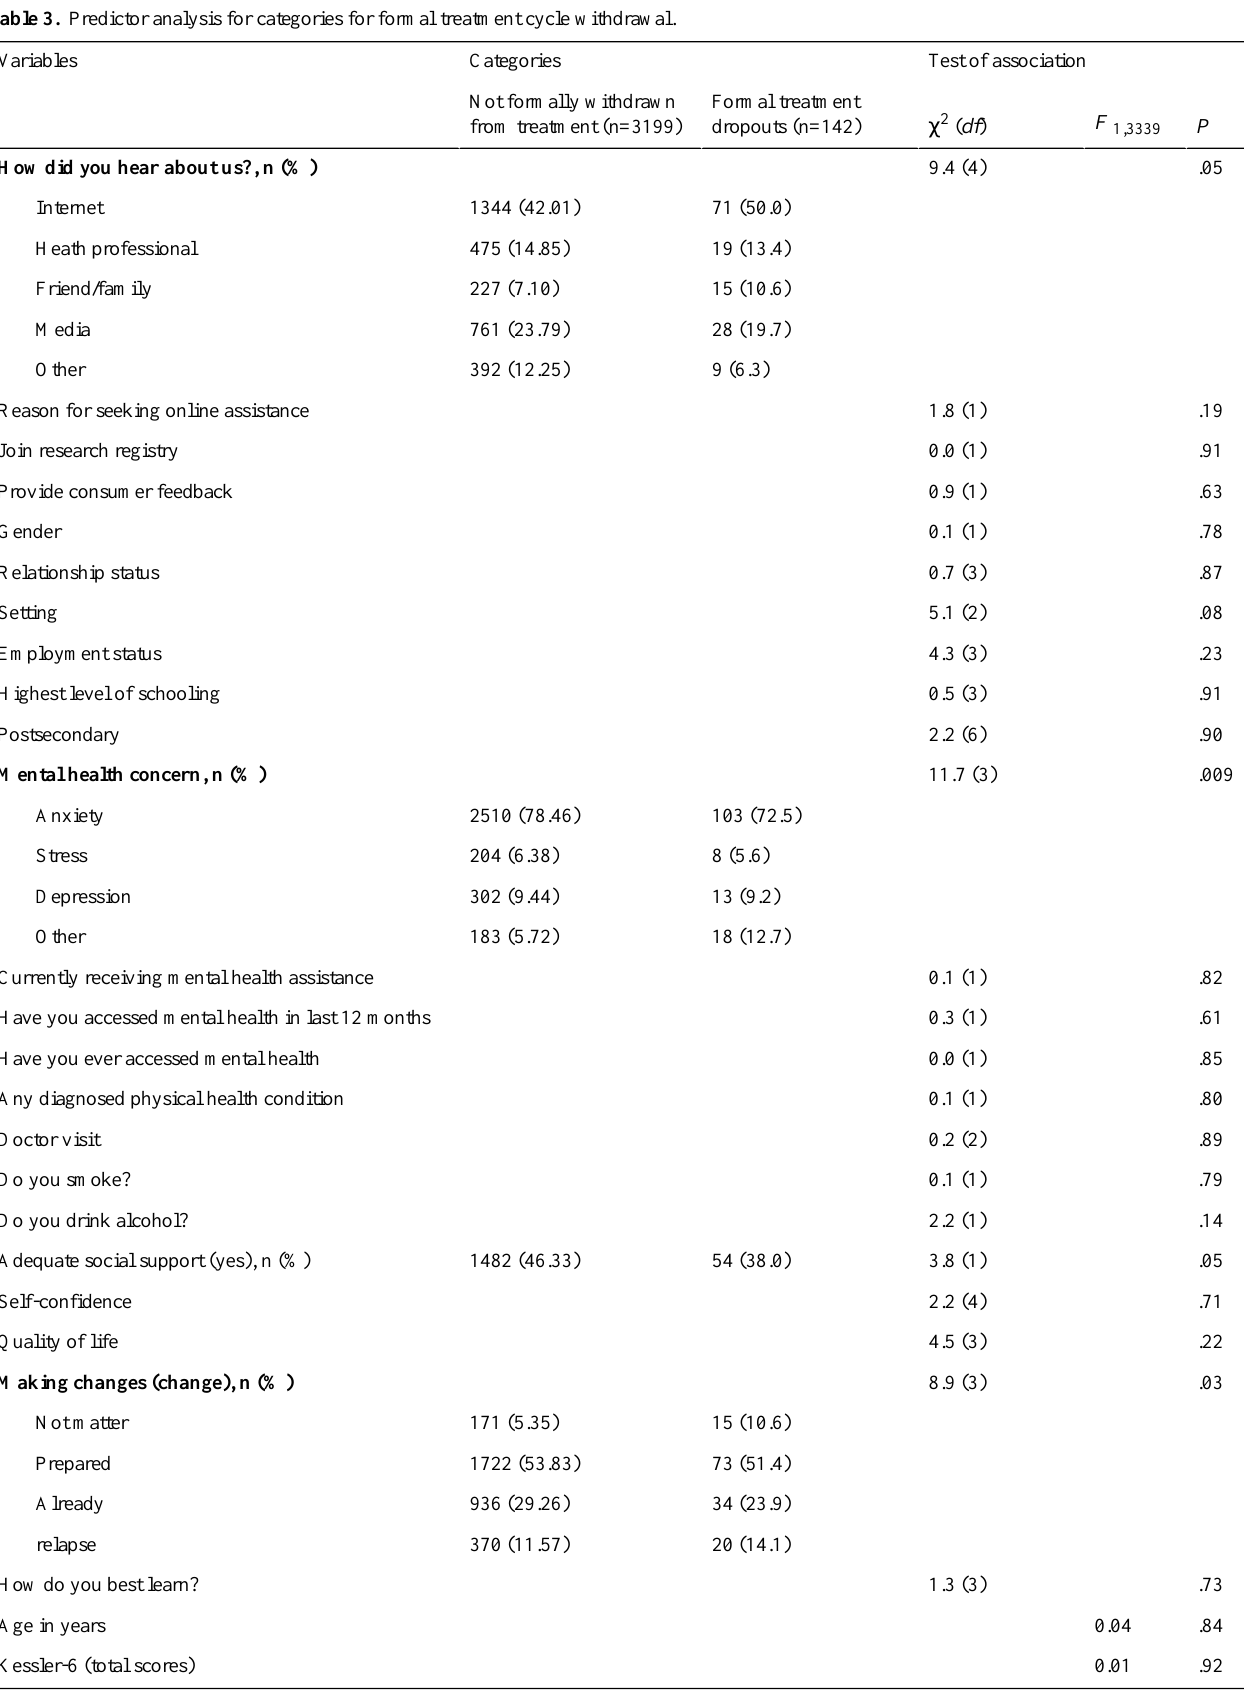
Table 3. Predictor analysis for categories for formal treatment cycle withdrawal.